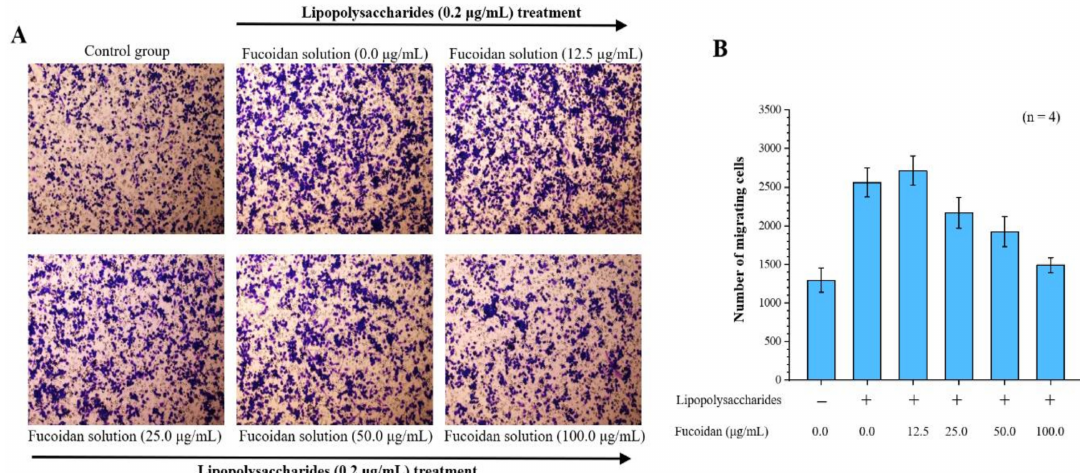
Figure 1. Anti-cell migration e ffi cacy of fucoidan. Migrated cells were stained with 0.2% crystal violet. ( A ) Microscopic images of migrated RAW 264.7 cells at 24 h (4 replicates). Magnification: 100 × ; ( B ) Quantitative analysis of stained migrated cancer cells using Metamorph software are presented as means ± standard deviations (SD) ( n =